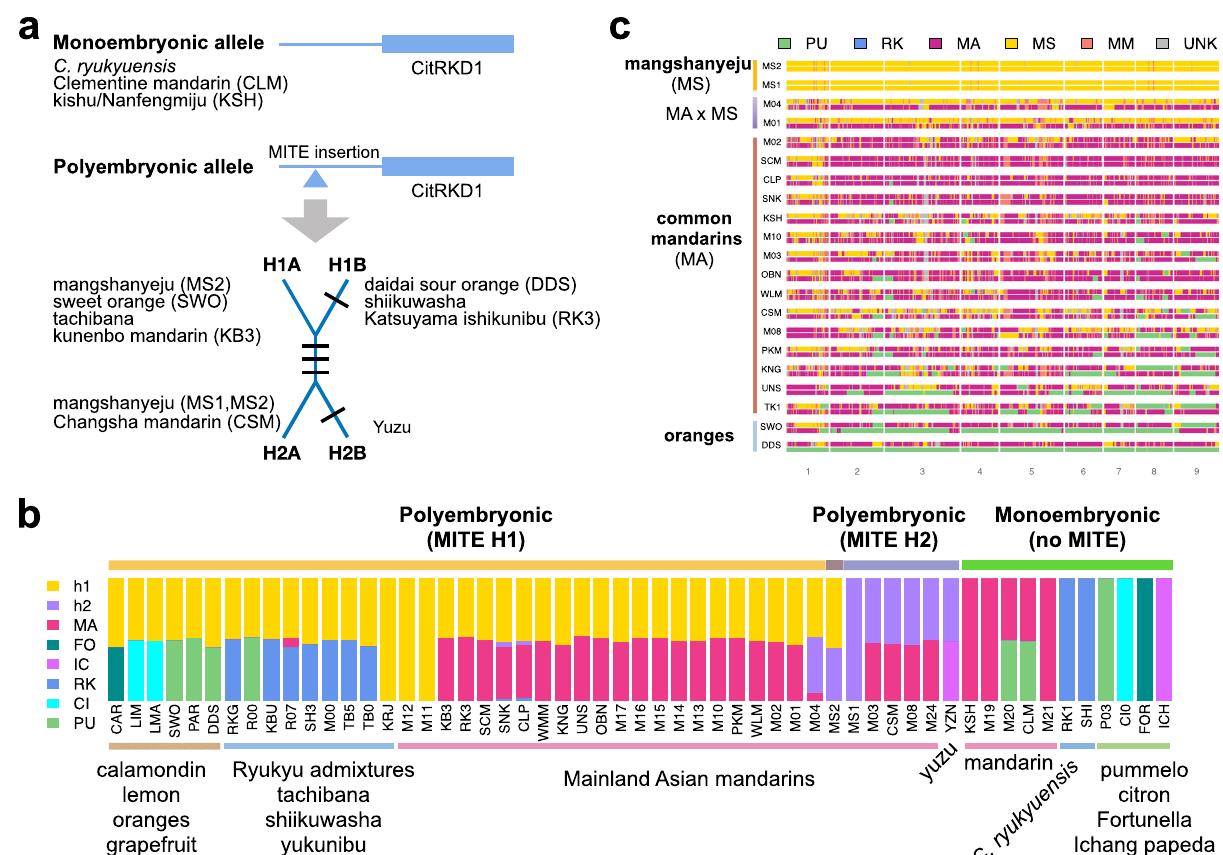
Fig. 4 Ancestry of apomixis alleles and two subspecies of mainland Asian mandarins ( C. reticulata ). a Diversity of the apomixis alleles in mandarins and inter-speci fi c mandarin hybrids. The ancestral allele does not have the MITE transposon insertion in the promoter of the CitRKD1 gene regulating citrus apomixis. Derived alleles with the MITE insertion are dominant for the nucellar embryony phenotype. Four MITE haplotypes in two haplogroups (H1 = H1A and H1B; H2 = H2A and H2B) are observed among sequenced mandarins and hybrids with each black line denoting a segregating SNP. Listed next to each MITE allele type are representative citrus accessions containing that allele. b Genetic ancestry of the citrus polyembryonic locus (200 kb region fl anking CitRKD1 gene). Fifty- fi ve accessions derived from six progenitor species are analyzed with ADMIXTURE 68 and the eight-population ( K = 8) structure is presented with additional fi gures shown in Supplementary Fig. 8. (PU = pummelo, CI = citron, RK = C. ryukyuensis , IC = Ichang papeda, FO = Fortunella (kumquat), MA = common mandarin, h1 and h2 have mangshanyeju ancestry). Accessions with h1 ancestry contain MITE H1A or H1B, whereas those with h2 ancestry have MITE H2A or H2B. MS1 and MS2 are two mangshanyeju accessions. All sequenced polyembryonic accessions carry the dominant allele with the MITE insertion and have mangshanyeju ancestry at this locus, whereas monoembryonic accessions have common mandarin but not mangshanyeju ancestry. c Genome-wide local ancestry inference of mainland East Asian citrus with four ancestral populations including two subspecies of C. reticulata (MS, MA). Population code as in Fig. 1b. This fi gure complements Fig. 3b by considering 21 accessions without C. ryukyuensis ancestry. Note that the apomixis locus is located near the end of chromosome 1 (based on the Clementine reference sequence) which exhibits extensive MS admixture in common mandarins relative to other chromosomes. MS admixture is widespread in all sequenced mandarins. Two wild mandarins (M01 = Daoxian wild mandarin and clonal relatives, M04 = Suanpangan) show hybrid ancestry with nearly equal contribution from MS and MA. Source data underlying Fig. 4b and c are provided as a Source Data fi